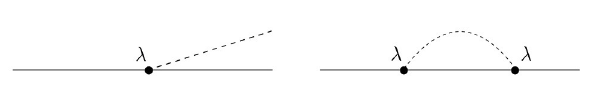
FIGURE 8 | Topologically non-trivial processes: (Left) a baby universe (dotted line) is emitted from a parent universe (solid line). (Right) a wormhole is represented by the emission and absorption of a baby universe line by a parent